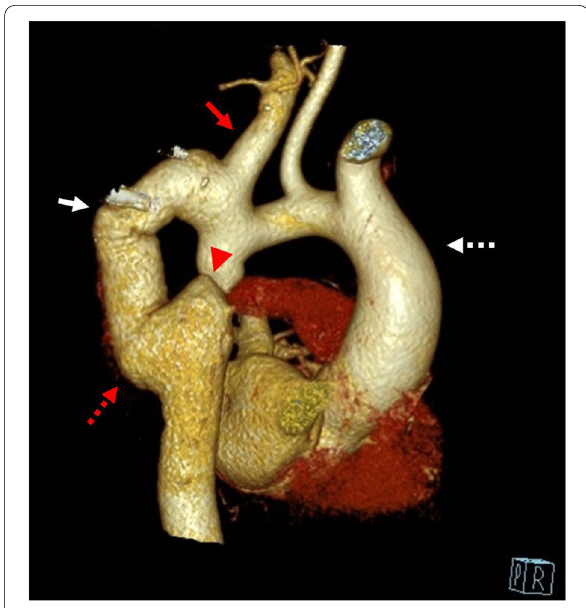
Fig. 3 CT angiography of thorasic aorta (3D reconstruction). Red Arrow:the left Subclavian artery is ectatic, reflecting a more diffuse arteriopathy, Arrow head: Aortic interruption, Red Dashed arrow: pseudoaneurysm of distal anastomotic site, White arrow: pseudoaneurysm of mid posterior part of the tube graft. White Dashed Arrow: Ascending Aorta